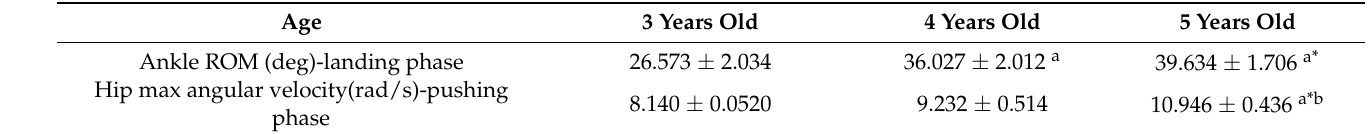
Table 6. Results of age effect of joint angle.